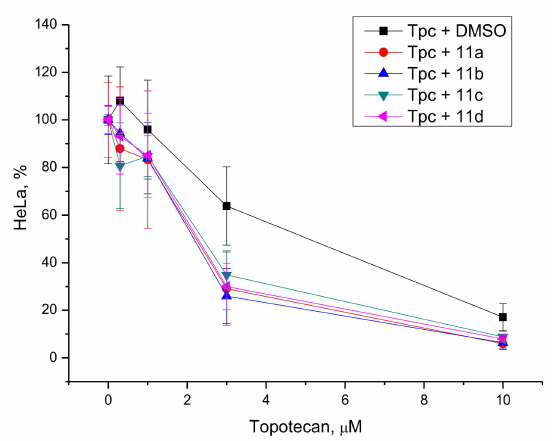
Figure 10. Dose-dependent action of the Tpc with 11a , 11b , 11c , and 11d (5 µ M) on HeLa cells’ viability. Both 11a and 11c showed synergistic effect with Tpc reducing viability in the HeLa cell line, but stimulated cell growth of non-cancerous HEK293A